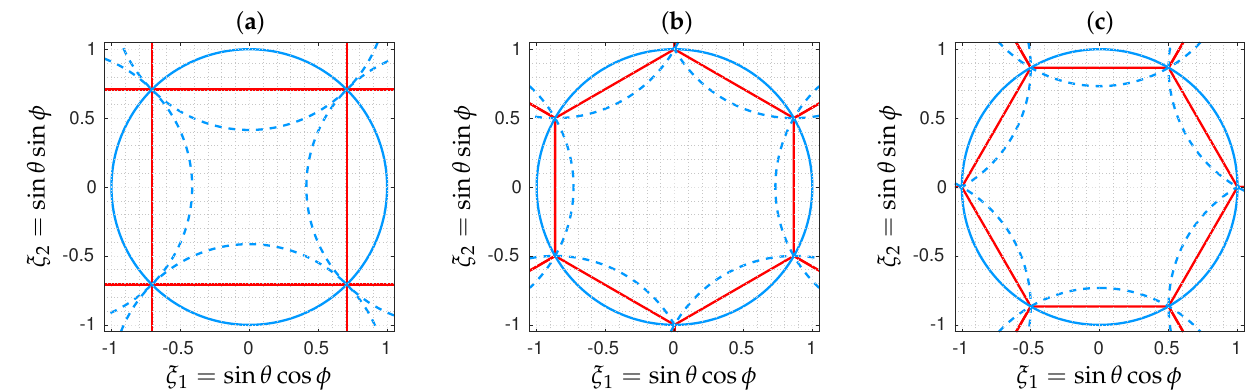
Figure 2. Synthesized field of view (red) and limit of the 2 π sr space (blue) in front of antenna arrays √ leading to ( a ) a Cartesian geometry here with d / λ = 2/2 and to ( b,c ) a hexagonal geometry here with d / λ = 2/3. The components ξ 1 = sin θ cos φ , ξ 2 = sin θ sin φ , and ξ 3 = cos θ of the angular position variable ξ are direction cosines in the reference frame of the arrays, θ and φ are the traditional polar coordinates (the colatitude and the azimuth, respectively). Shown with dashed blue lines are the sky aliases. Earth (and its aliases) is not shown as its location, and its extent in this direction cosines domain depends on the elevation and on the attitude of the platform.